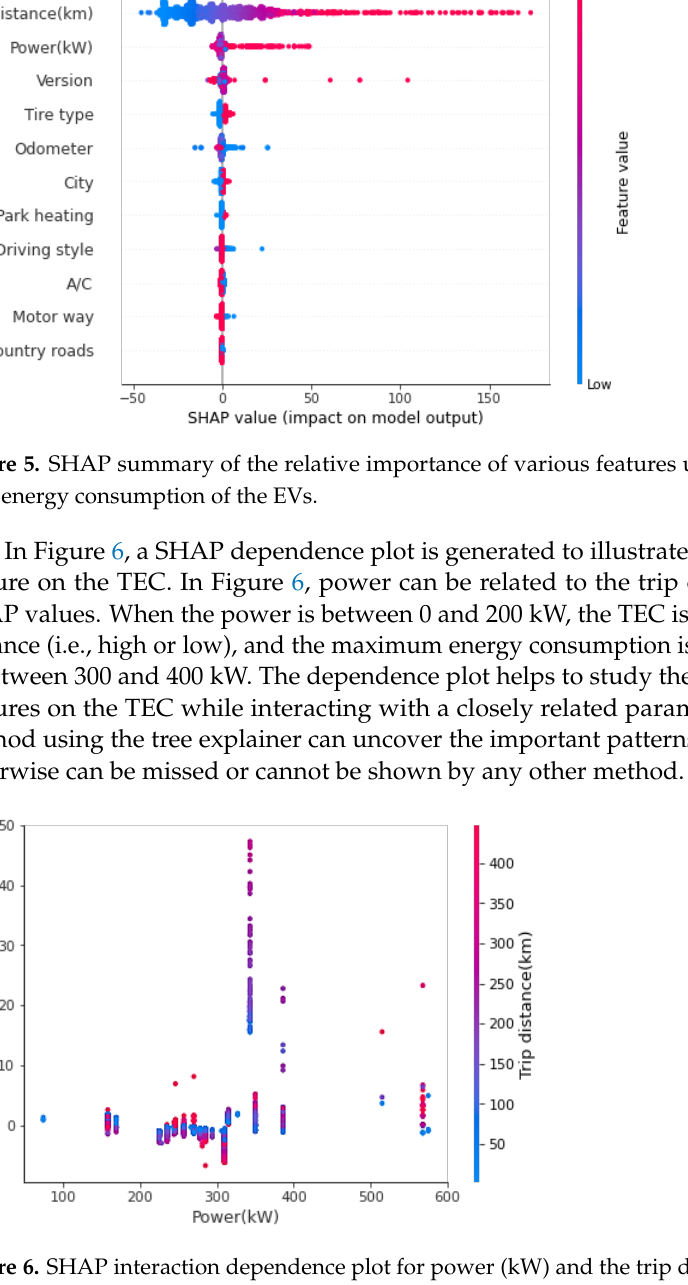
8 of 10 Figure 4. Plot of XGBoost ML model prediction for test data compared with the actual values. To examine the significant parameters that influence the TEC, SHAP was used. SHAP helps to explain the output obtained using machine learning models. The SHAP summary was obtained to illustrate which features have high predictive significance. In Figure 5, the features/parameters are arranged according to their level of importance, i.e., the fea-